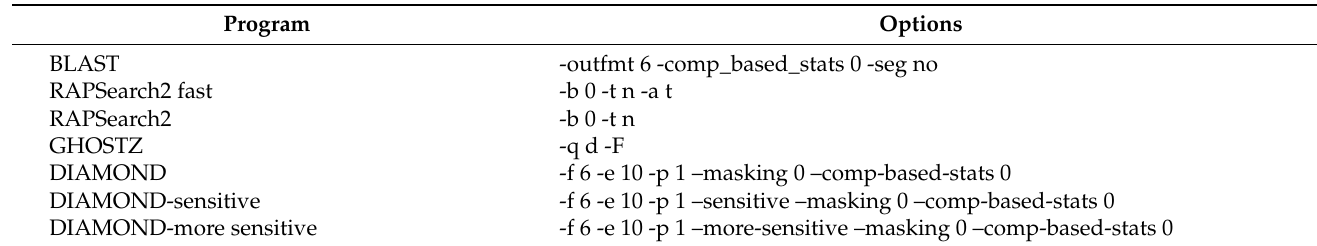
Table 1. Options for comparison programs.